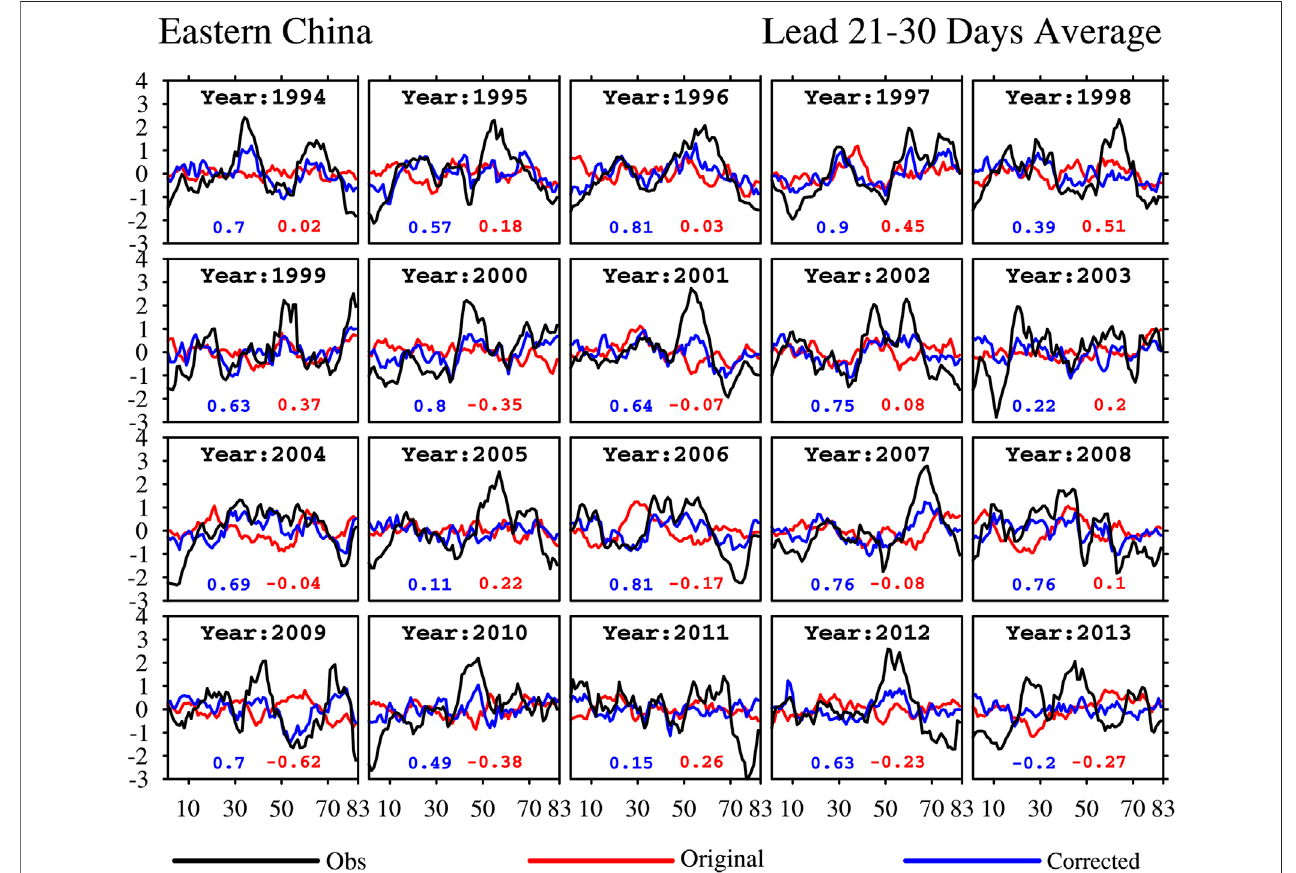
FIGURE 5 | Same as Figure 3 , but for the predictions with the forecast lead time of 21 – 30 days.